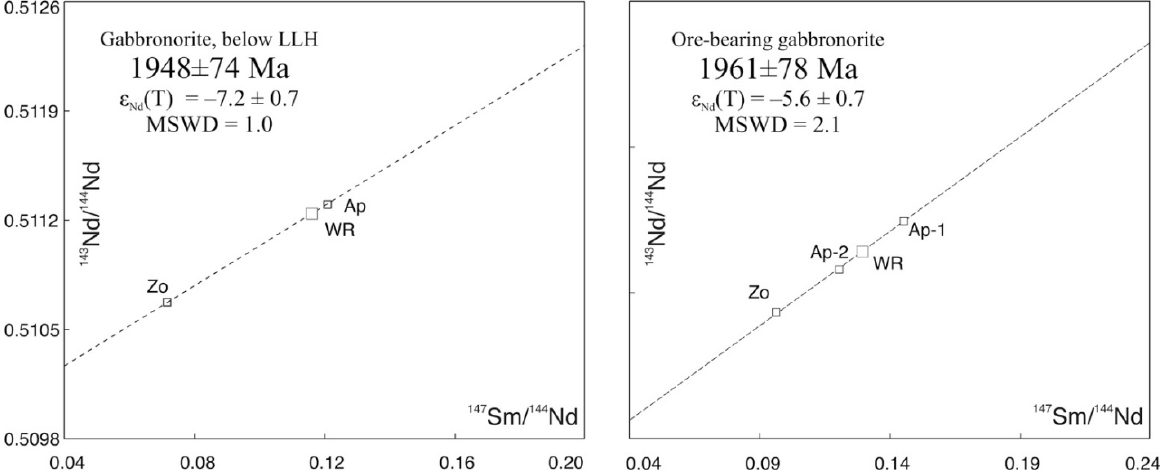
Figure 7. Metamorphic hydrothermal mineral Sm-Nd isochrones for gabbronorites of the North Kamennik deposit.